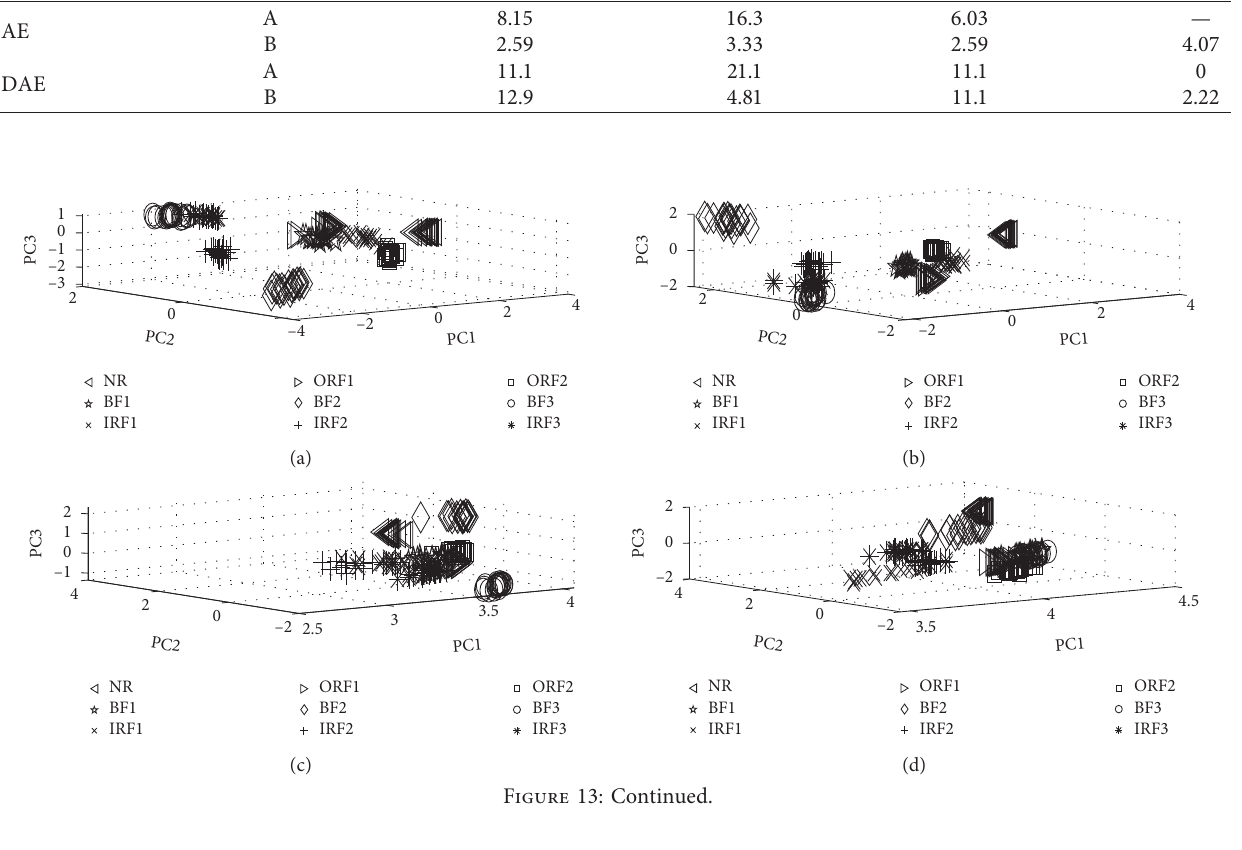
Table 4: The error classification accuracy obtained through various models (the training dataset).